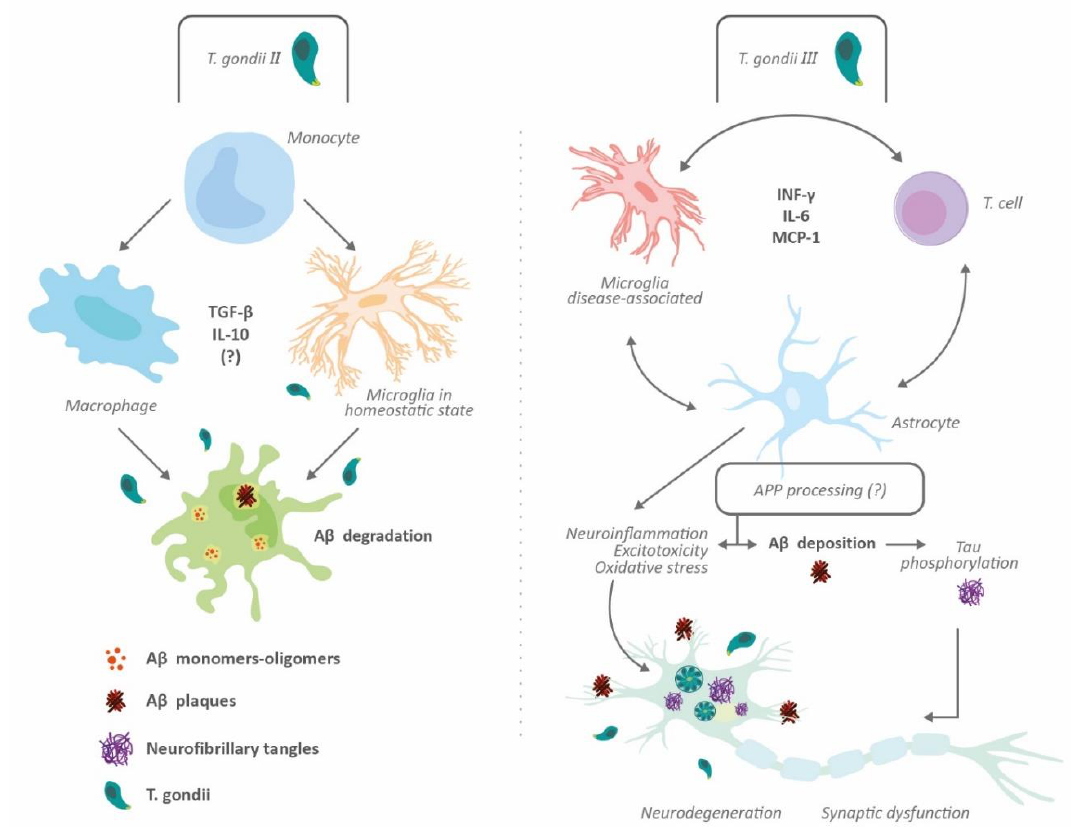
Figure 3. Impact of Toxoplasma gondii on amyloid processing and tau pathology. The effects of toxoplasmosis on Aβ plaque formation depends on Toxoplasma strains. Thus, Type II induces the activation of monocyte-derived cells (macrophage and microglia), possible immunomodulation and protective effects against Aβ depositi on (left panel); Type III produces an elevated inflammatory response and nonprotective effects on Aβ deposition and tau phosphorylation (right panel). Neurodegeneration, synaptic dysfunction, and changes in neuronal microenvironment may underlie cognitive impairment induced by T. gondii. Type I Toxoplasma reduces amyloid precursor protein (APP) levels and induces downregulation of Presenilin 2 (PSEN2) and Casein Kinase 1 Alpha 1 (CSNK1A1) genes. The effects of Type II and Type III infection on APP processing is unknown. Abbreviations: Amyloid beta peptide (Aβ); amyloid precursor protein (APP); Casein Kinase 1 Alpha 1 (CSNK1A1); Interferon gamma (INF- γ ); Interleukin (IL); Monocyte chemoattractant protein-1 (MCP-1); Presenilin 2 (PSEN2); Transforming growth factor-beta (TGF- β